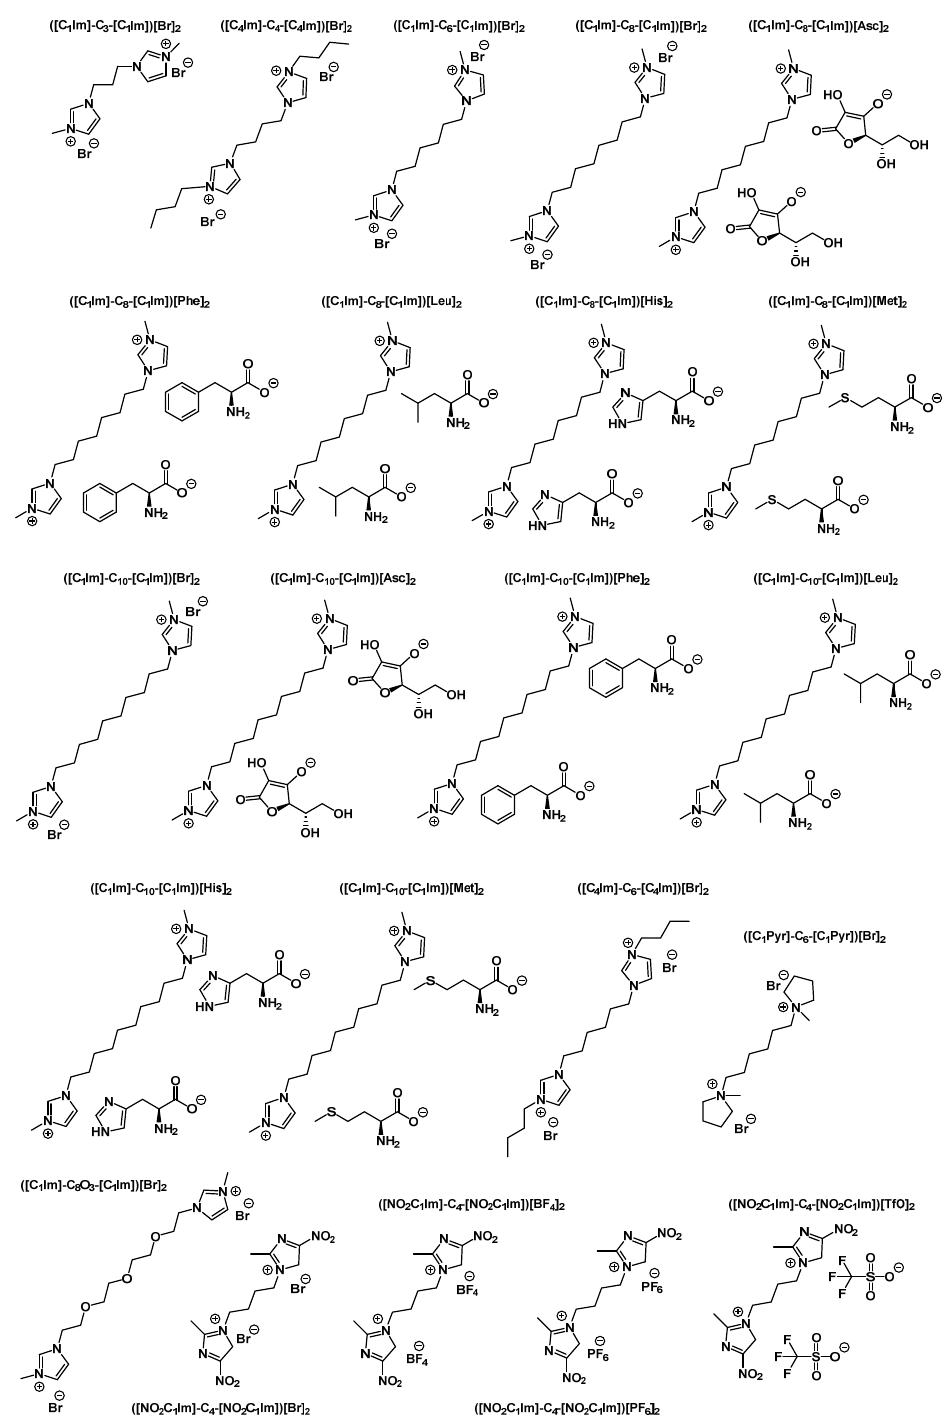
Figure 30. Examples of dicationic ILs with tested antimicrobial activity. The numbers of substances correspond to those in Table 5.